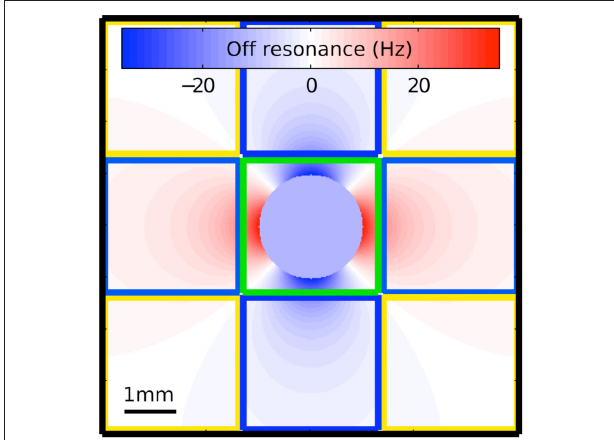
FIGURE 2 | Magnetic field off resonance distribution around the cross section of a large vein perpendicular to the main magnetic field. This simulation uses the venogram scan parameters in our study and assumes a typical blood oxygenation fraction of 0.54 (Haacke et al., 1995). The voxel outlined in green covers the entire cross section of the vein but samples only a limited portion of the off resonance distribution. This voxel is expected to have high magnitude fSNR but low phase fSNR because the off resonance field distortions sampled by it vary symmetrically around 0Hz and the T2 * of venous blood is short relative to that of the parenchyma. The voxels outlined in blue sample from the field distribution adjacent to the vein. These voxels have low magnitude fSNR but high phase fSNR because the field distortions sampled by them vary weakly and tend to be of a single polarity. The voxels outlined in yellow sample portions of the field distribution that are mostly on resonance. These voxels have very little magnitude and phase